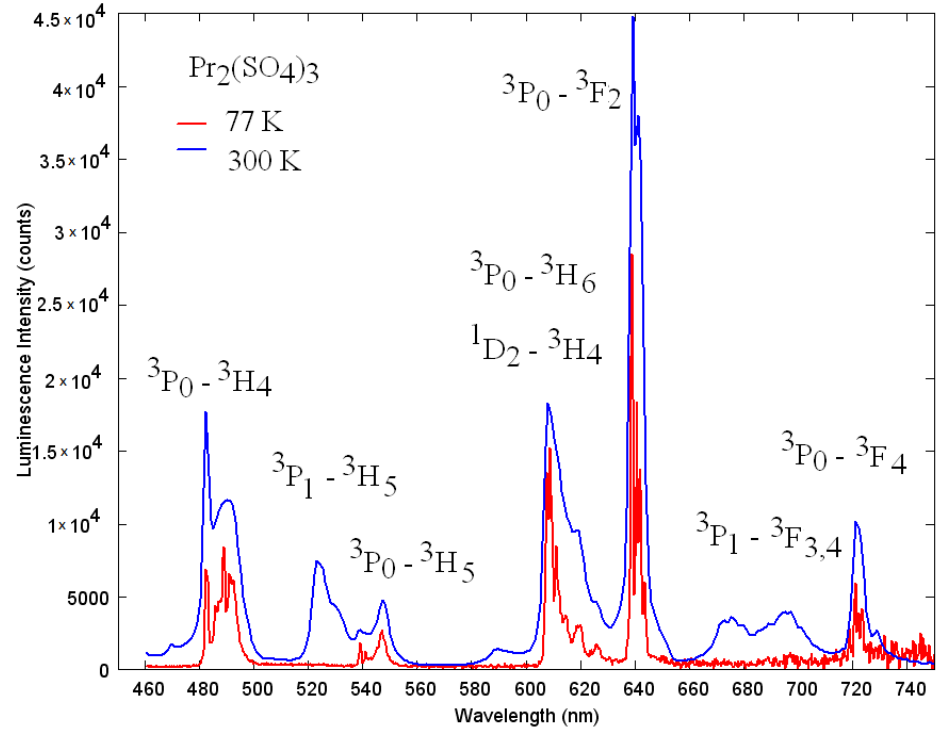
Figure 11. High resolution emission spectra of Pr 2 (SO 4 ) 3 at room temperature (blue) and at 77 K (red) excited at 440 nm.